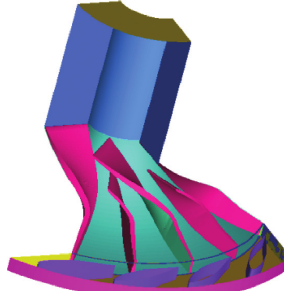
Figure 4: Power turbine.